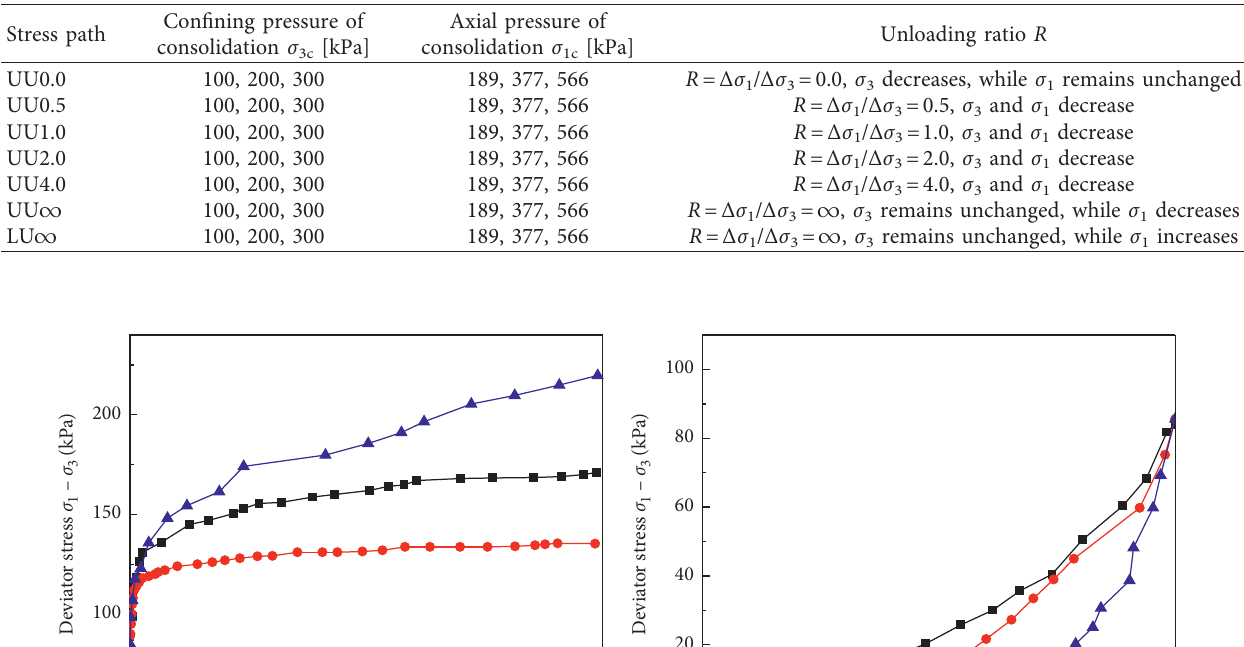
Table 2: Test plan of unloading/loading stress path.